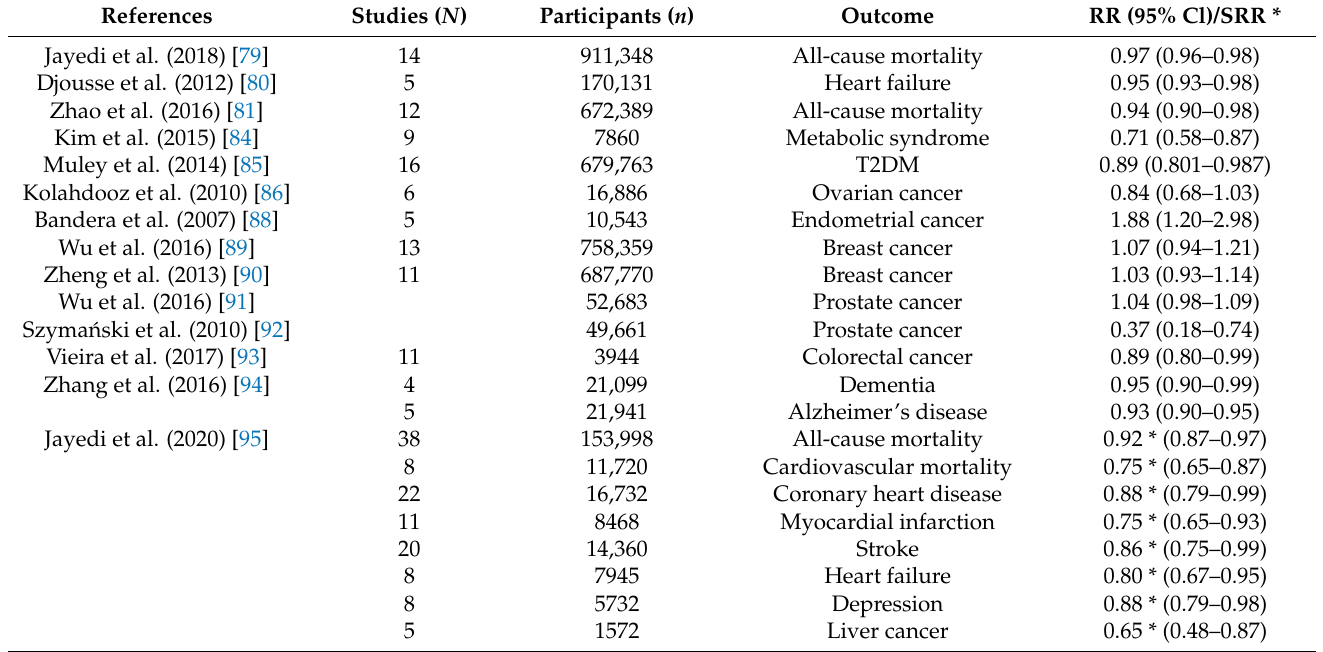
Table 1. Summary of significant potential health benefits of fish consumption in previous